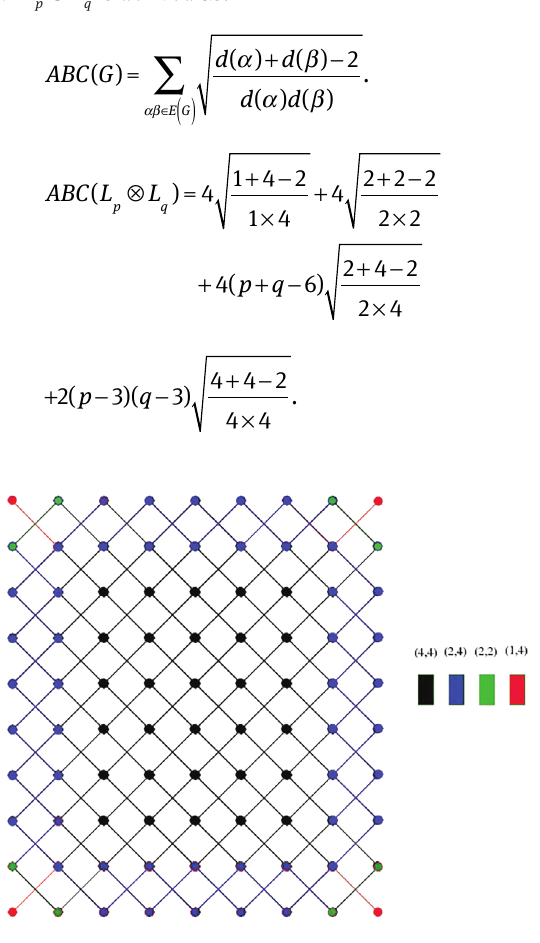
⊗ L that depend on the 9 10